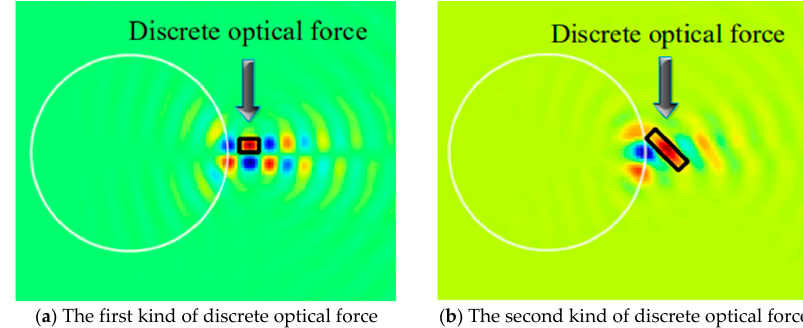
Figure 6. ( a , b ) The different kinds of discrete optical forces.